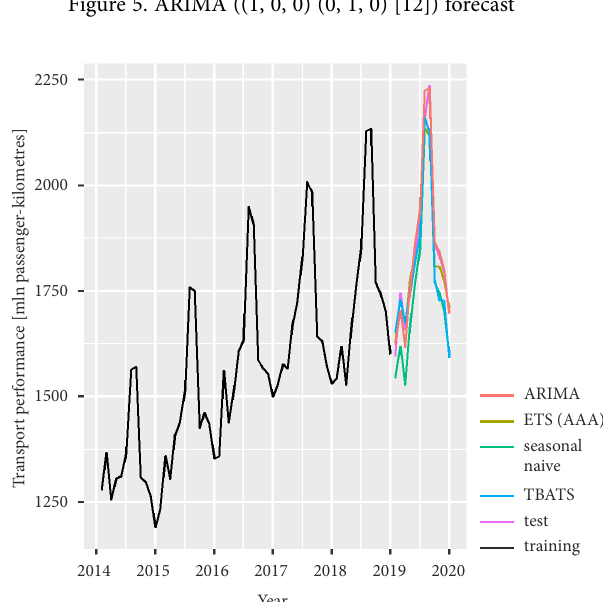
Figure 6. Forecasts from all models constructed in this study Table 5. Comparison of selected forecast errors for all